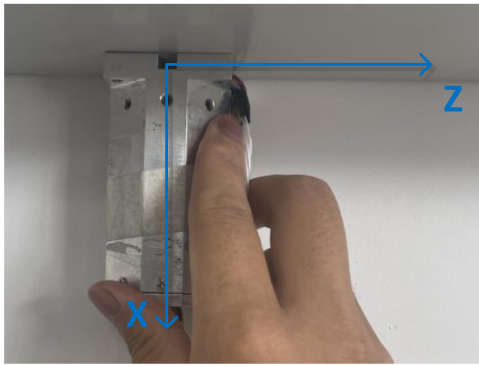
Figure 12. Position 1 in the TPC method. position 2 as shown in Figure 13.